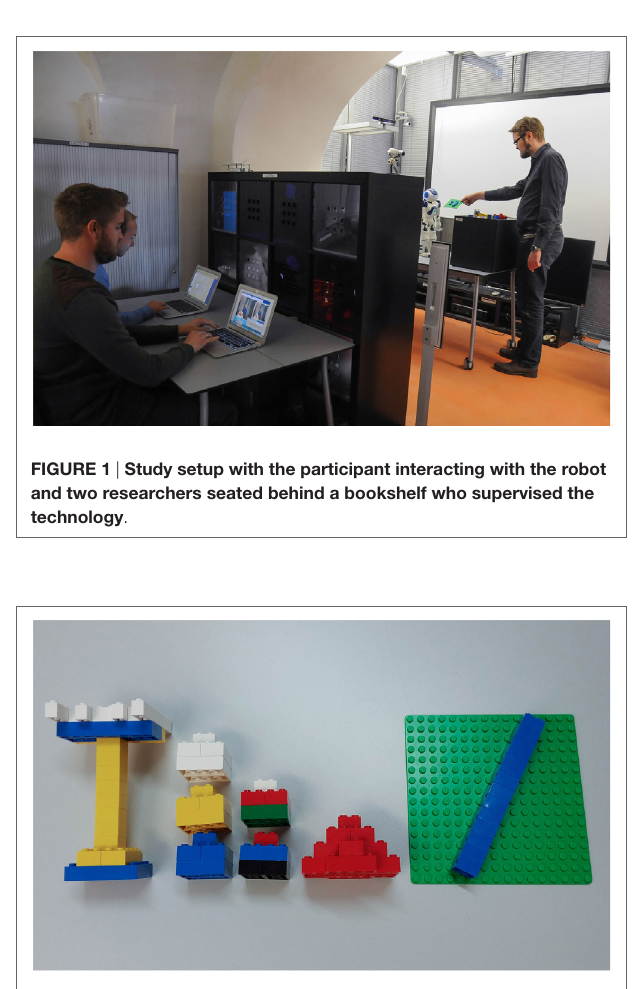
FigUre 2 | legO blocks that were provided to the participants .